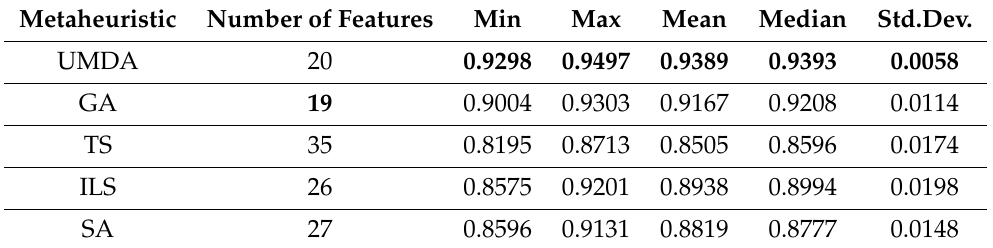
Table 1. Statistical analysis of the performance obtained for the feature selection task with 5 search strategies. The number of features corresponds to the number of features used in their best result.